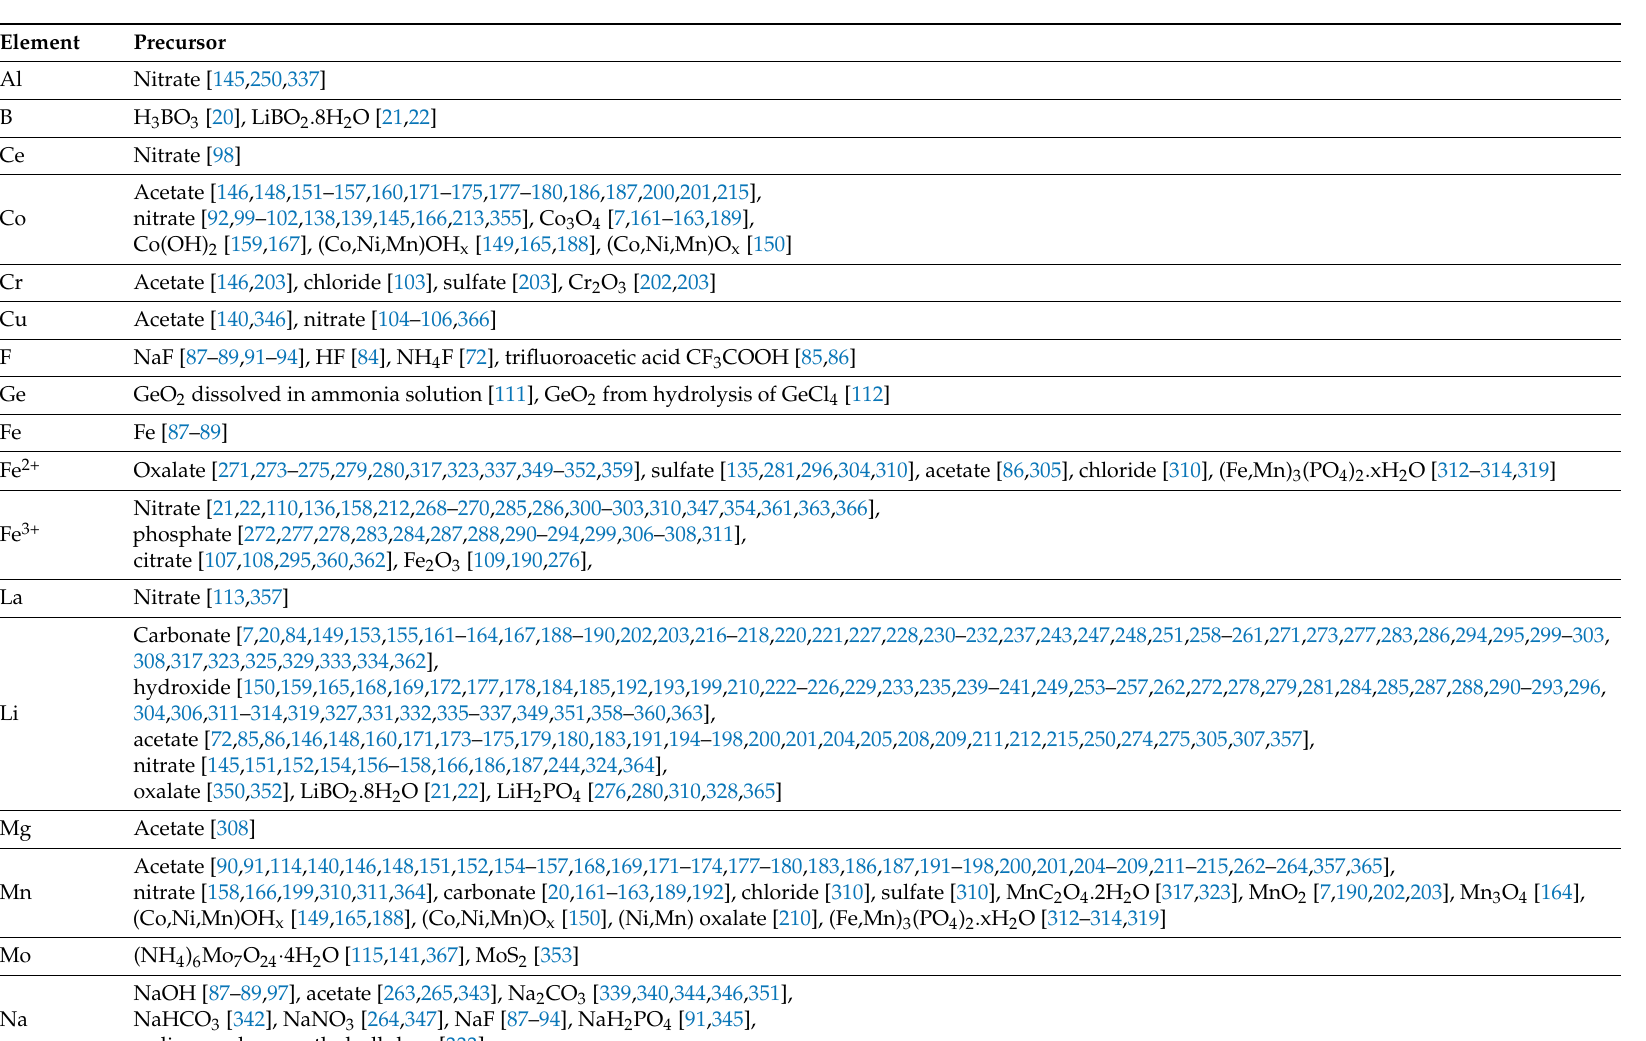
Table A2. Inventory of the starting materials used in the publications referenced in this